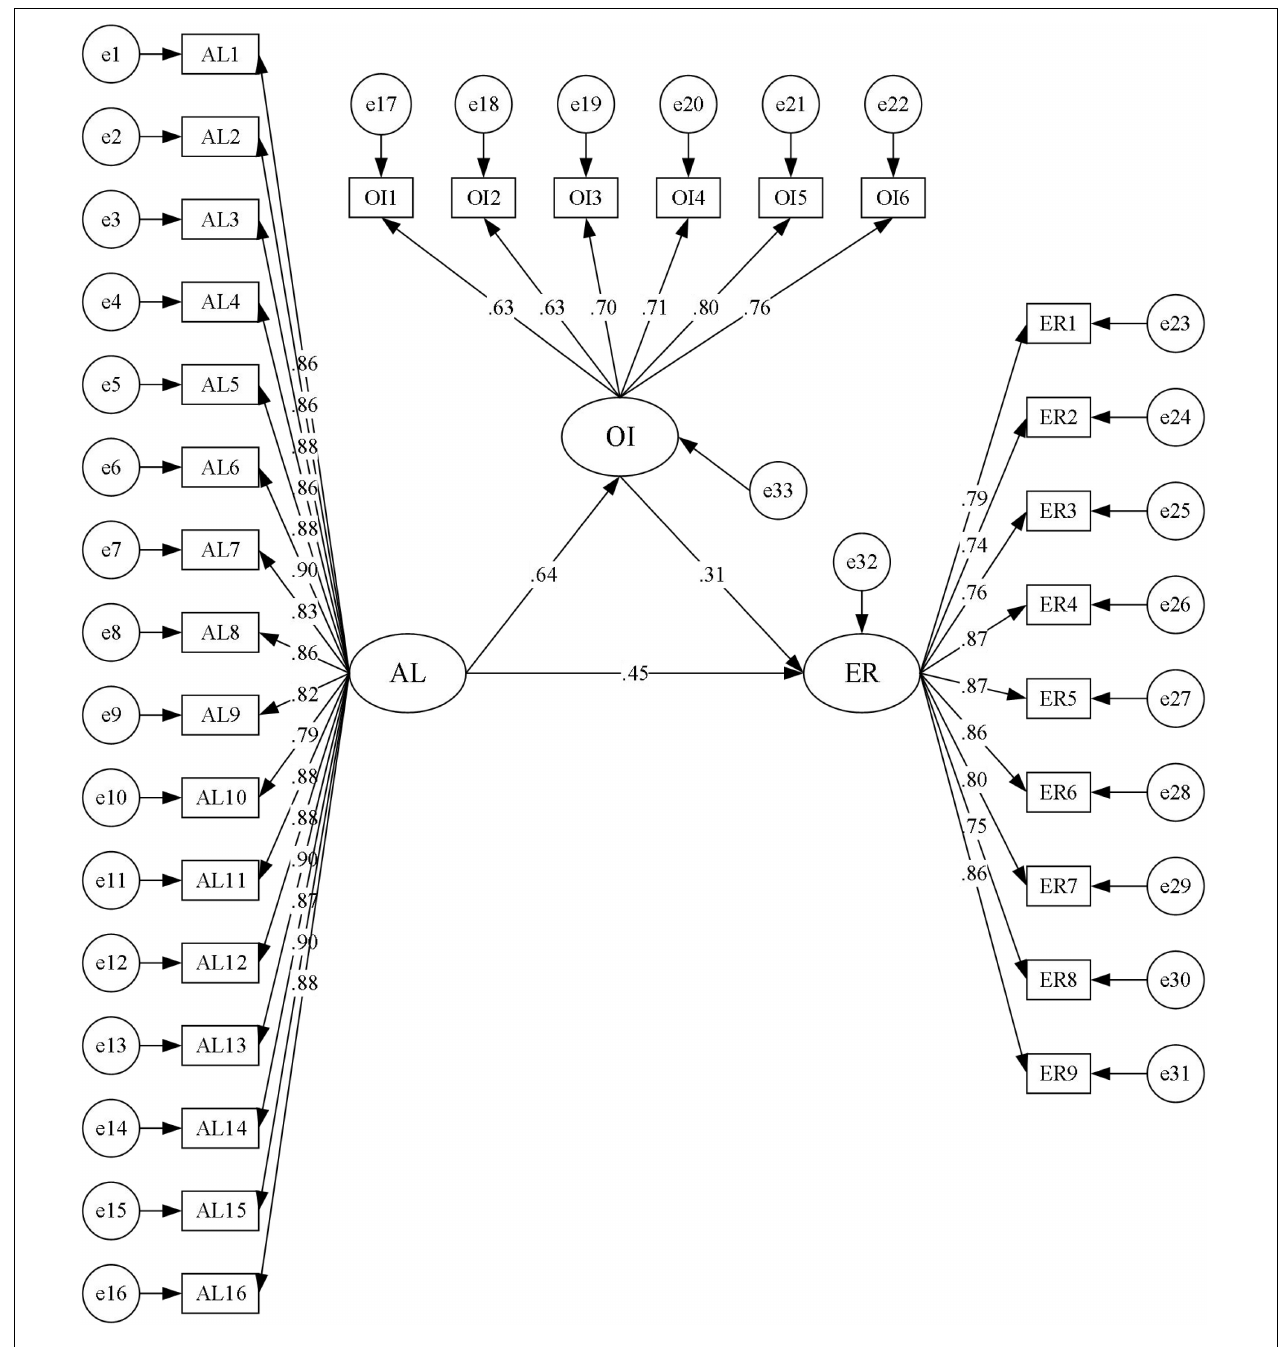
FIGURE 2 | Test of the mediation